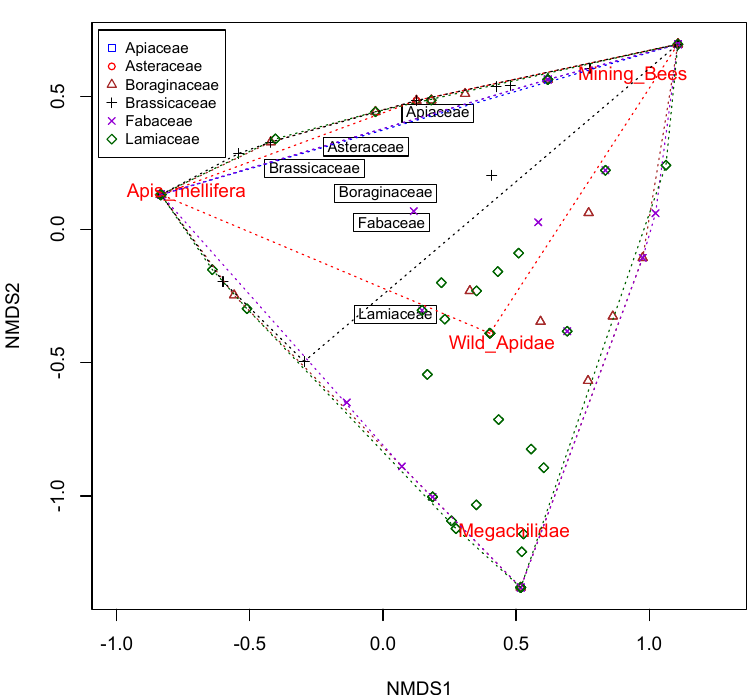
Figure 6. Plot of the scores of the first two components for the different plant families (symbols) and bee groups (red labels) in the of non-metric multidimensional scaling (NMDS). The black labels indicate the centroids for the different plant families.